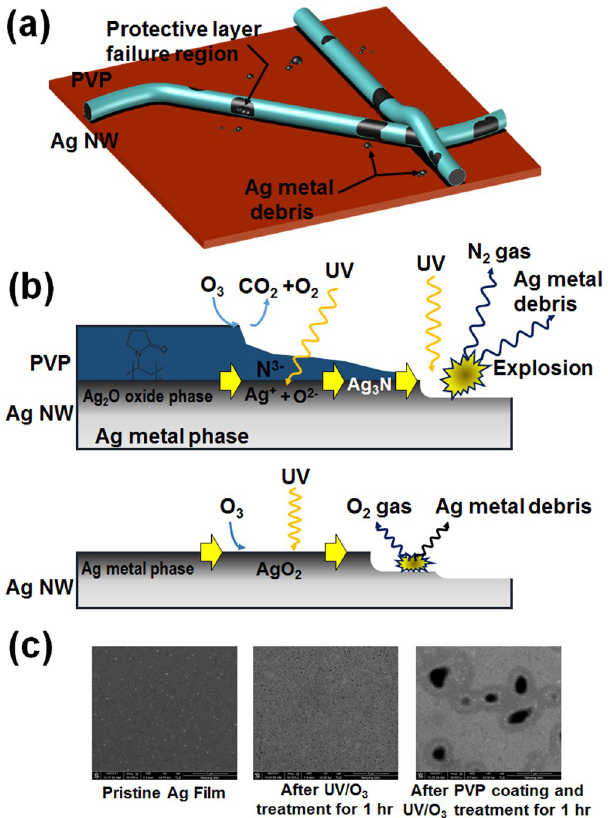
Figure 6. Schematic diagrams for the ( a ) cross-sectional images of the Ag NWs and for the ( b ) chemical reactions on the surfaces of the Ag NWs. ( c ) Scanning electron microscopy images for the pristine silver film with a 100-nm thickness, for the silver film after UV/O 3 treatment for 1 hr, and for the silver films after polyvinylpyrrolidone coating and UV/O 3 treatment for 1